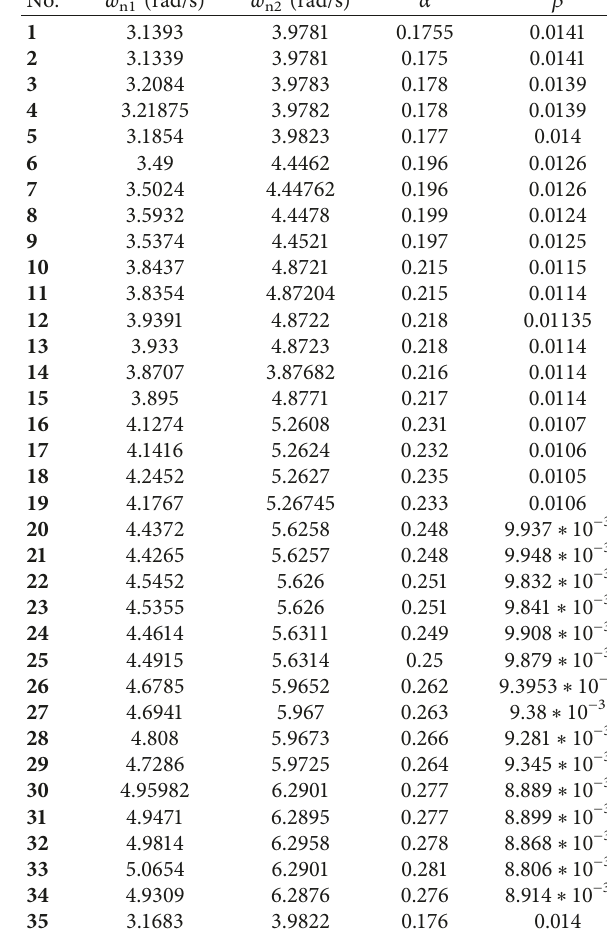
Figure 4: The first and second vibration frequencies and modes for model 4 in Table 2.